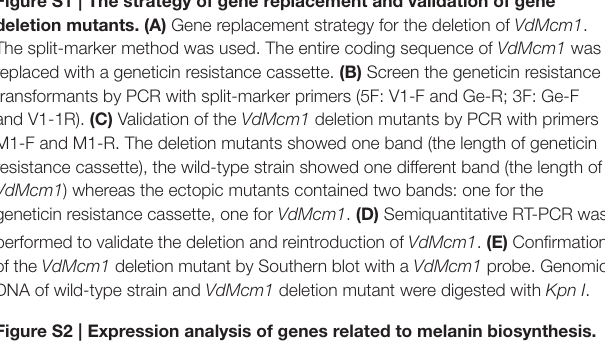
Figure S1 | The strategy of gene replacement and validation of gene deletion mutants. (A) Gene replacement strategy for the deletion of VdMcm1 . The split-marker method was used. The entire coding sequence of VdMcm1 was replaced with a geneticin resistance cassette. (B) Screen the geneticin resistance transformants by PCR with split-marker primers (5F: V1-F and Ge-R; 3F: Ge-F and V1-1R). (C) Validation of the VdMcm1 deletion mutants by PCR with primers M1-F and M1-R. The deletion mutants showed one band (the length of geneticin resistance cassette), the wild-type strain showed one different band (the length of VdMcm1 ) whereas the ectopic mutants contained two bands: one for the geneticin resistance cassette, one for VdMcm1 . (D) Semiquantitative RT-PCR was performed to validate the deletion and reintroduction of VdMcm1 . (E) Confirmation of the VdMcm1 deletion mutant by Southern blot with a VdMcm1 probe. Genomic DNA of wild-type strain and VdMcm1 deletion mutant were digested with Kpn I . Figure S2 | Expression analysis of genes related to melanin biosynthesis. Calculation the transcript levels of five melanin biosynthesis genes with qRT-PCR. The β -tubulin gene was used as a reference gene for the expression analyses. The error bars represent standard deviations. The experiments were performed in triplicate. Figure S3 | Scanning electron microscopy of smoke tree roots inoculated with conidial suspensions. Arrows show germinated conidia in the wild-type and complemented strains. The pictures were taken after 24 h of incubation with 10 6 conidia/ml. Figure S4 | Validation of mRNA-Seq expression patterns by qRT-PCR. The qRT-PCR results of the selected genes showed similar expression patterns to those detected by mRNA-Seq. VDAG_08640 and VDAG_08676 are bZIP transcription factor genes; VDAG_03208 is a C 2 H 2 transcription factor gene; VDAG_00190 is a gene involved in melanin biosynthesis; VDAG_01206 is a pyruvate kinase gene which catalyzes the generation of pyruvate from phosphoenolpyruvate in glycolysis pahtway. The error bars represent standard deviations. The experiments were performed in triplicate. Figure S5 | VdMcm1 regulates genes expression of secondary metabolism gene clusters. (A) Line graph showing the expression pattern of secondary